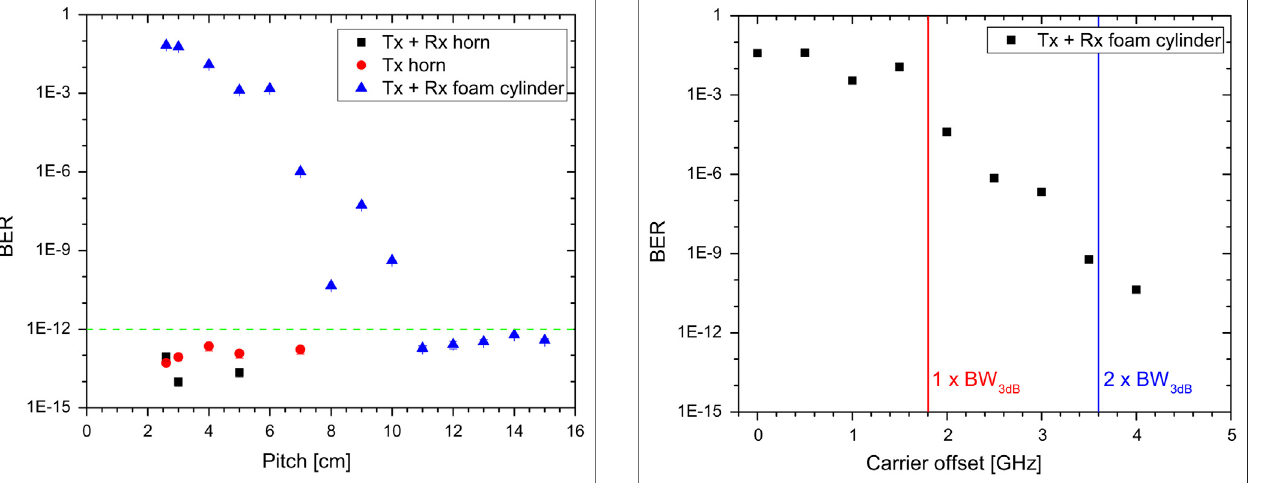
FIGURE 10 | Measured BER of two parallel-operated links at a pitch of 2.6 cm as function of the carrier frequency offset. The links are operated with MSK at up to 1.76 Gbps. No directive antennas are used. The 3 dB bandwidth of the Hititte transceivers (1.8 GHz) is indicated as red line, twice the bandwidth as a blue line